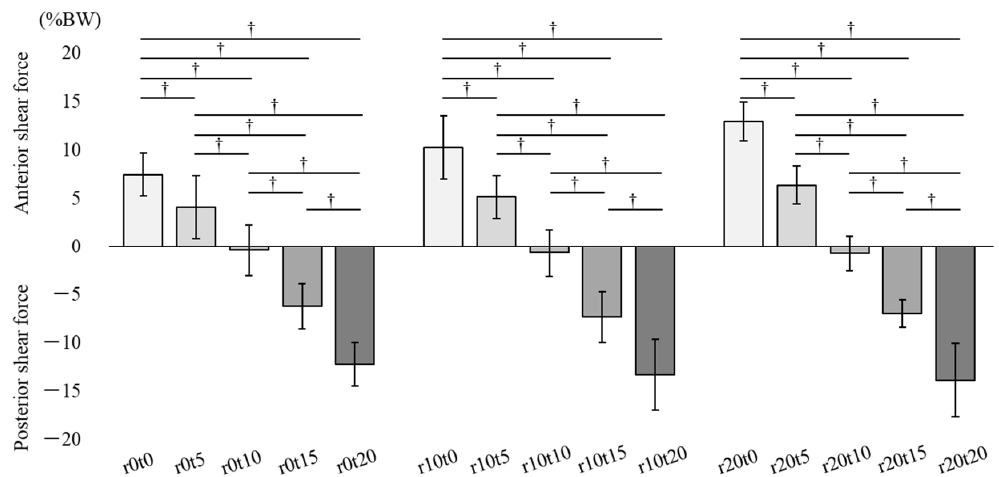
Figure 3. Sagittal component of the shear force. The positive value in the sagittal component represents the anterior shear force that occurs on the buttocks, and the negative value represents the posterior shear force. r: reclining, t: tilt-in-space. † There were significant differences of tilt-in-space condition in the simple main effect test.